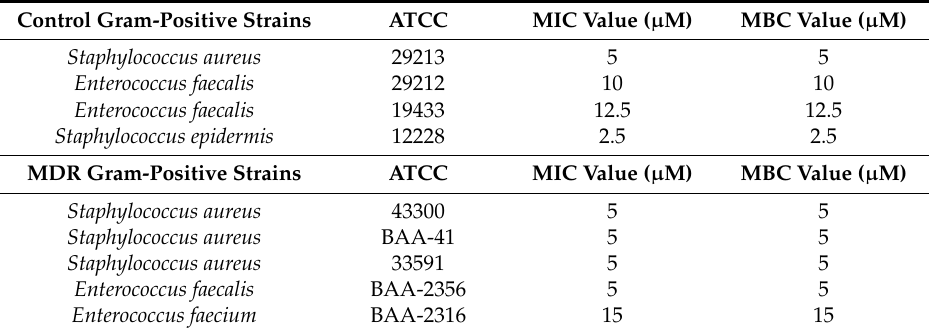
Table 2. Summary of the MIC and MBC values of A3 against all tested bacterial strains. Results represent triplicates.